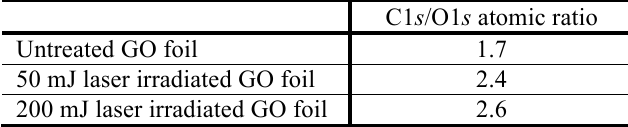
Table I . The values of the C1s/O1s atomic concentration ratio obtained by high resolution XPS spectra